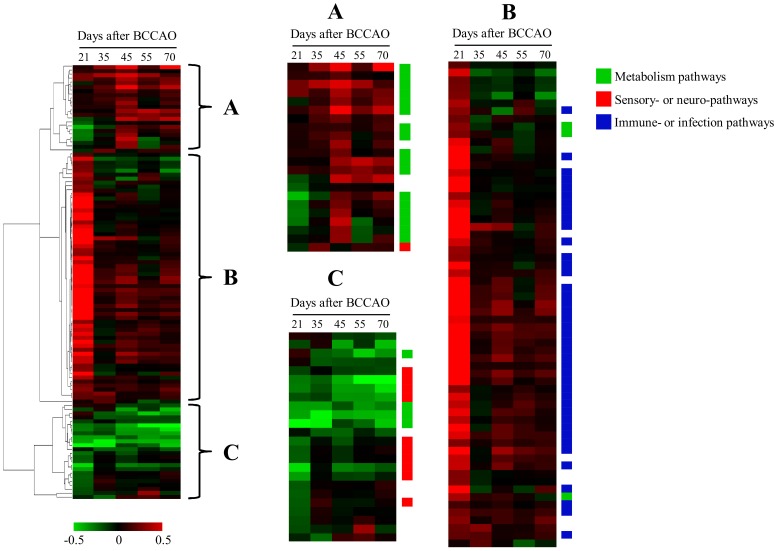
Pathway activities temporally altered in the hippocampus after BCCAO.Pathway activities were calculated by linearly combining gene expression level and then hierarchically clustered. The columns represent individual samples, while the rows represent the pathways. The red and green colors reflect high and low activity levels, respectively, as indicated by the scale bars with arbitrary unit. Three clusters (A, B, and C) are shown in detail. The positions of the pathways were colored green for metabolic pathways, red for sensory- or neuro-related pathways and blue for immune- or infection-related pathways.